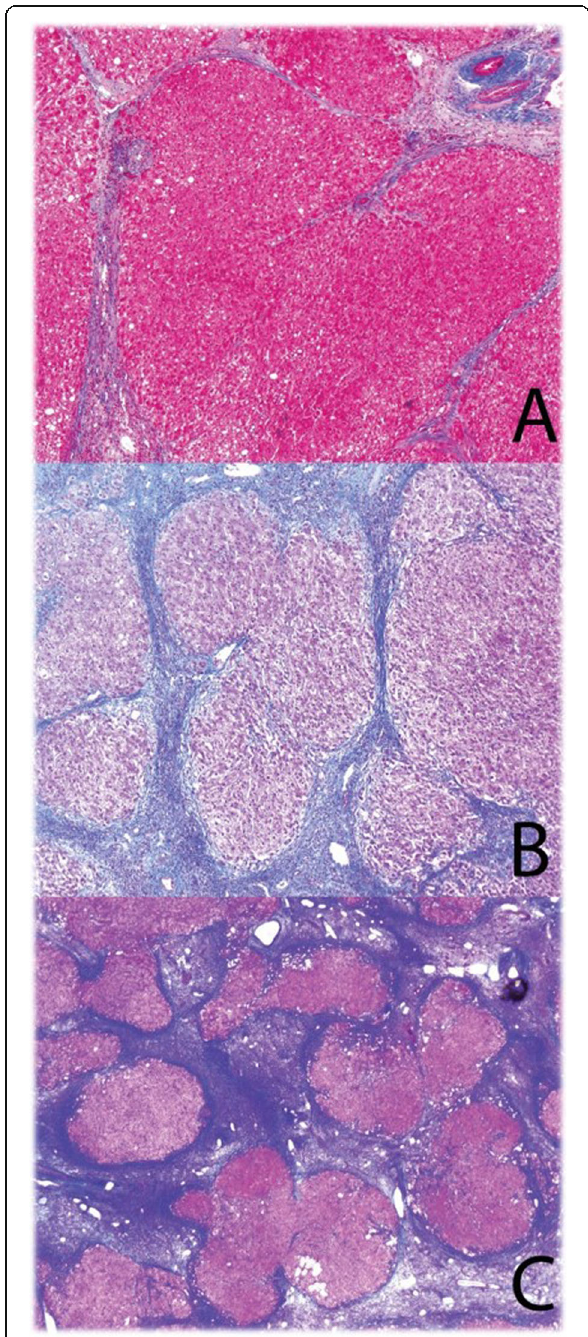
Fig. 1 Laennec staging in cirrhosis. a Laennec stage 4A is characterized by mild cirrhosis with delicate fibrous septae, trichrome stain. b Laennec stage 4B (moderate) cirrhosis with broad fibrous septae, trichrome stain. c Laennec 4 C (severe) cirrhosis with very broad septae, trichrome